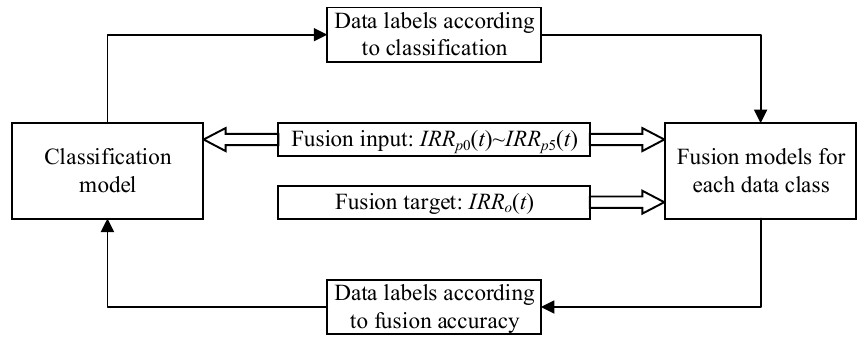
Figure 5. The fundamental of the proposed mutual optimization framework for pattern classification and data fusion models.